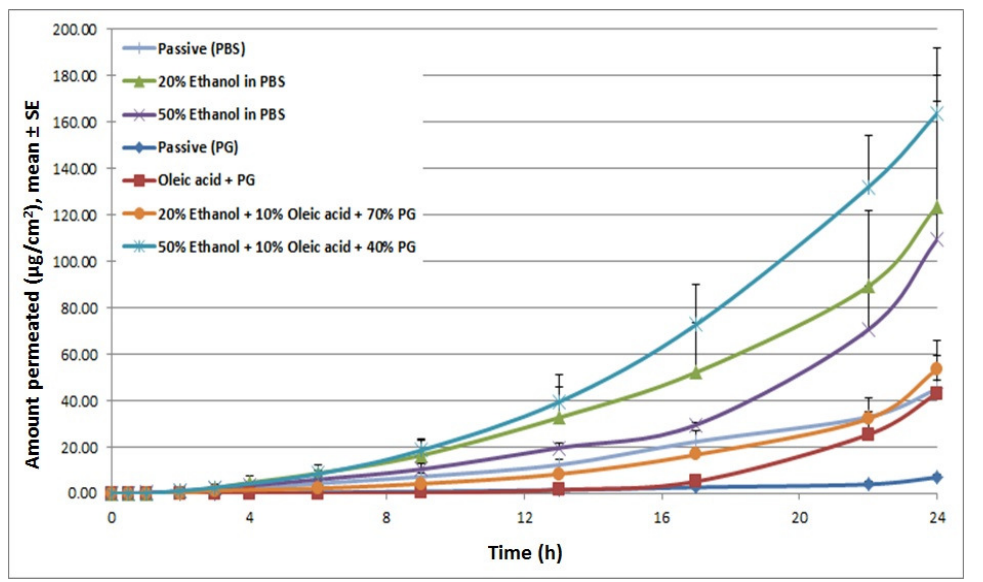
Figure 3. Effect of different chemical enhancers on permeation levels of